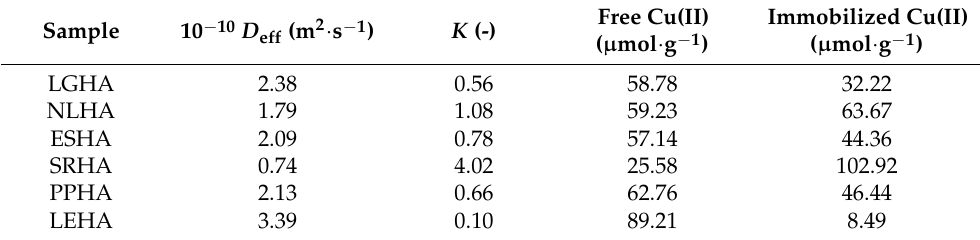
Table 2. Effective diffusion coefficients of Cu(II) ions in hydrogels enriched by different humic acids ( D eff ), apparent equilibrium constant ( K ) and contents of free movable and immobilized Cu(II) ions in